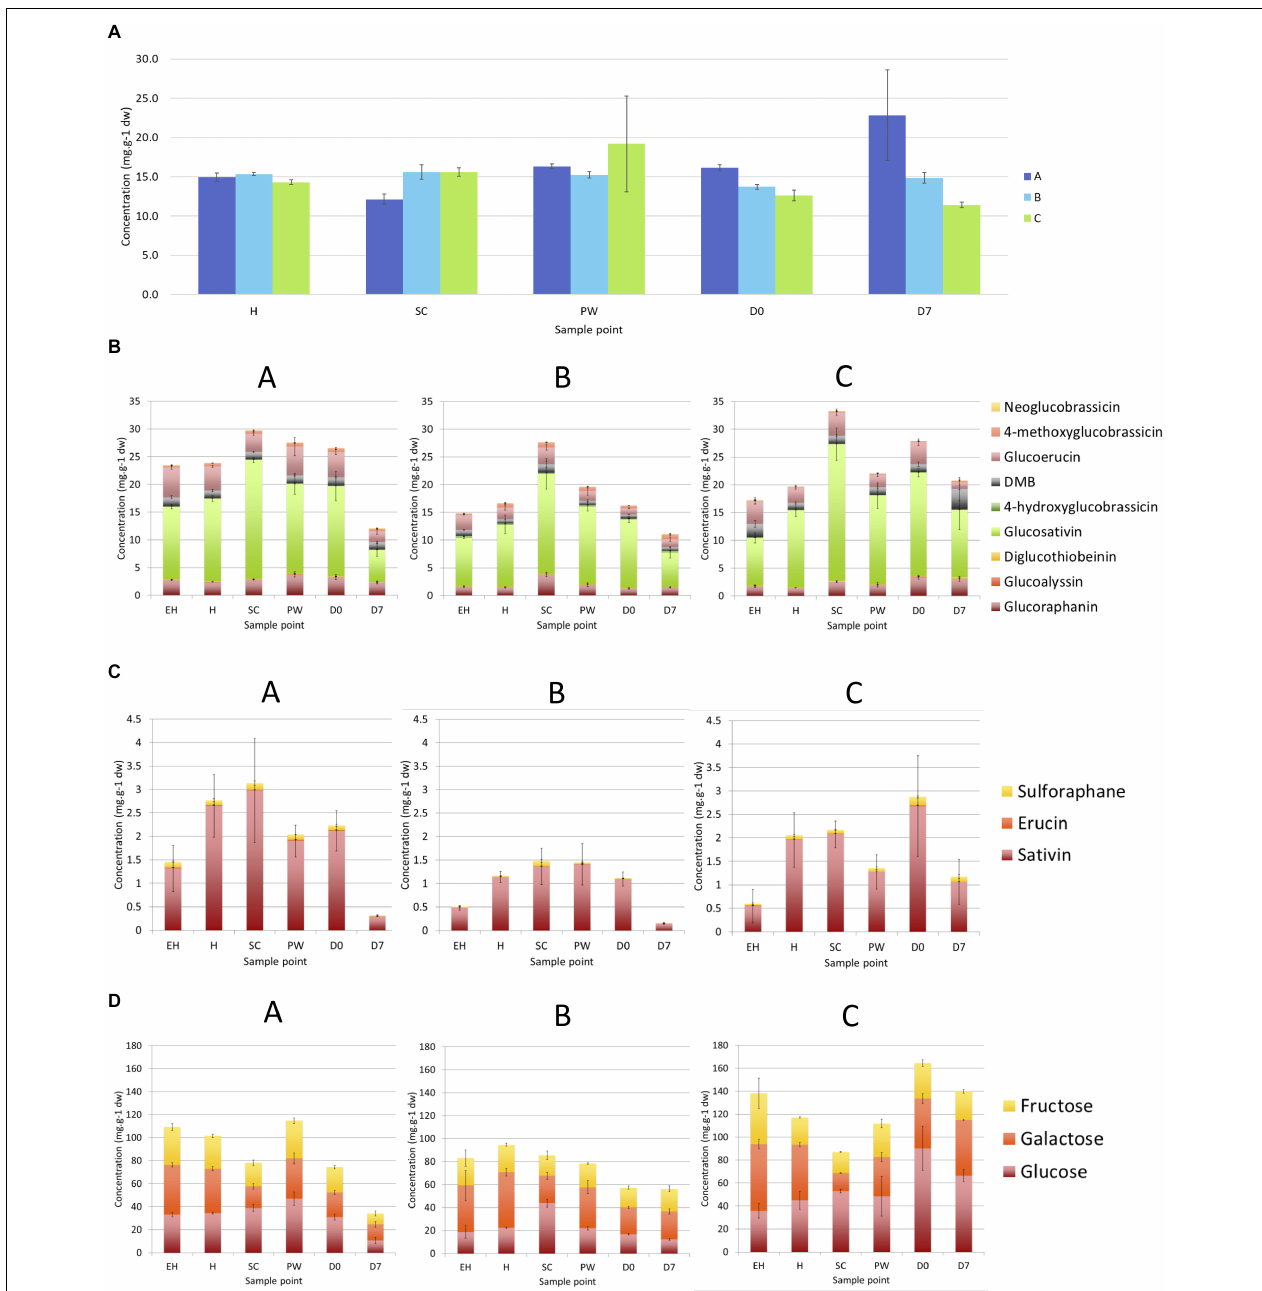
FIGURE 10 | Elemental sulfur (A) , glucosinolate (B) , glucosinolate hydrolysis product (C) , and monosaccharide (D) concentrations observed in elite inbred lines of Eruca sativa ( A , B , and C ). Concentrations are expressed as mg.g - 1 of dry weight. Error bars represent standard error of the mean of each analyte detected. See insets for compound color coding. For ANOVA and Tukey’s HSD pairwise significance values see Supplementary Data File 1 . EH , early harvest; H , harvest; SC , second harvest; PW , pre-wash; D0 , post-wash; and D7 , 7-day shelf